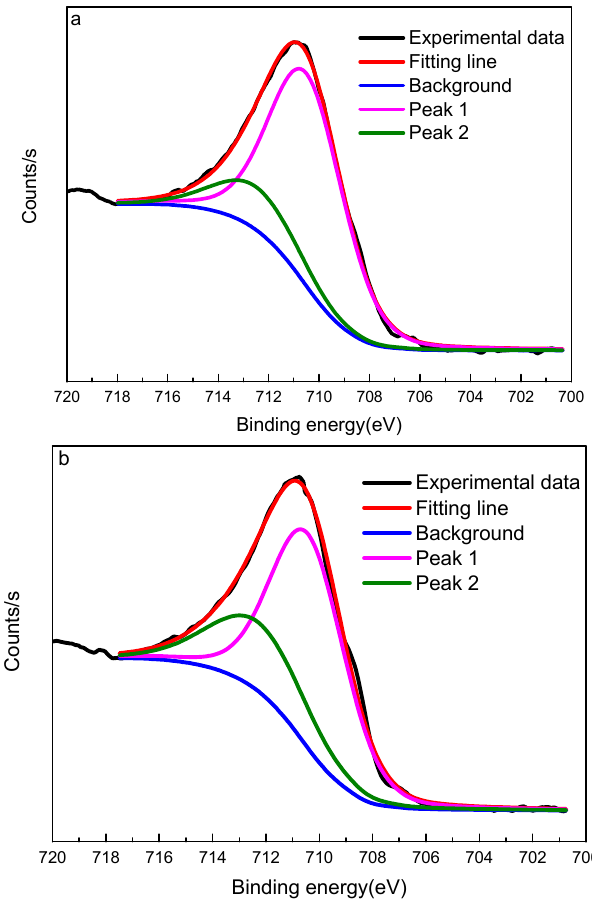
Figure 8. The results of X-ray photoelectron spectrometer (XPS) tests for raw ilmenite ore: ( a ) samples without attrition-scrubbing; ( b ) attrition-scrubbing samples.